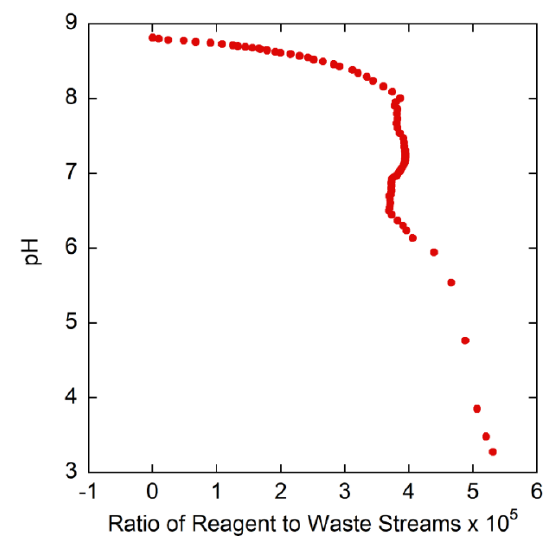
Figure 5. Ratio of Reagent to waste stream Vs pH.